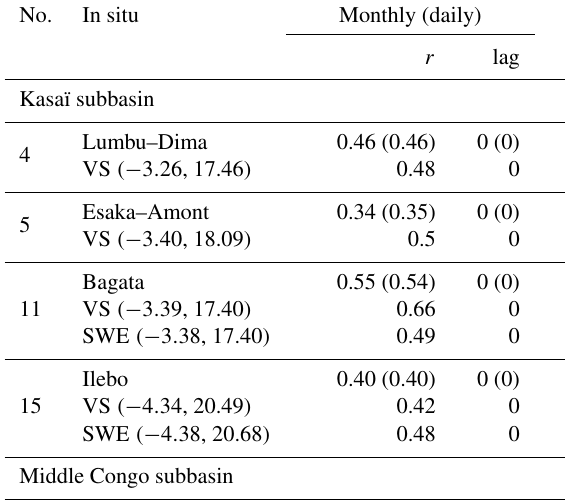
Table 3. Optimal coefficient correlation and associated lag for each in situ station against SWH and discharge at the Brazzaville/Kin- shasa station, with their closest VS and GIEMS-2 cell (SWE) and their latitude and longitude in parentheses (second column). In the last two columns, in parenthesis, the r and lag values are given at the daily timescale when daily observations are available. Only cor- relations with a 95% significance are reported.